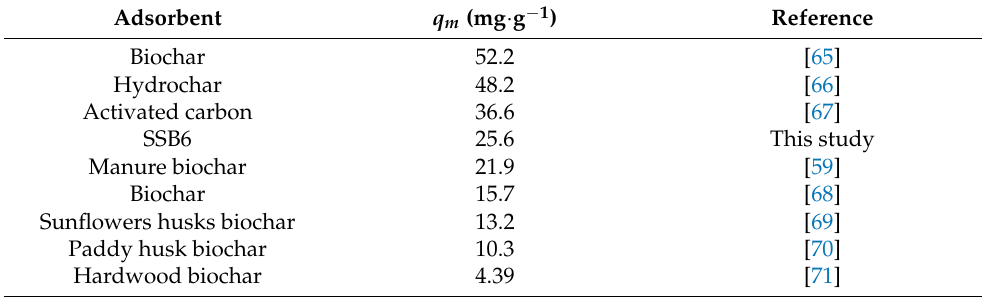
Table 10. Different adsorbents’ capacities for removing Cu 2+ cations from aqueous solutions.